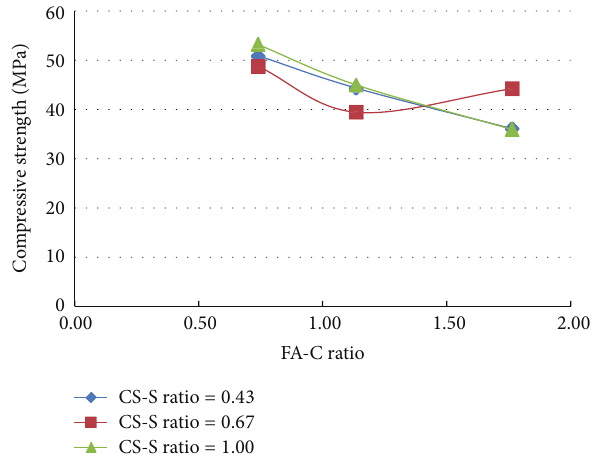
Figure 10: Compressive strength versus FA-C ratio (specimens S28– S36: with both fibres).